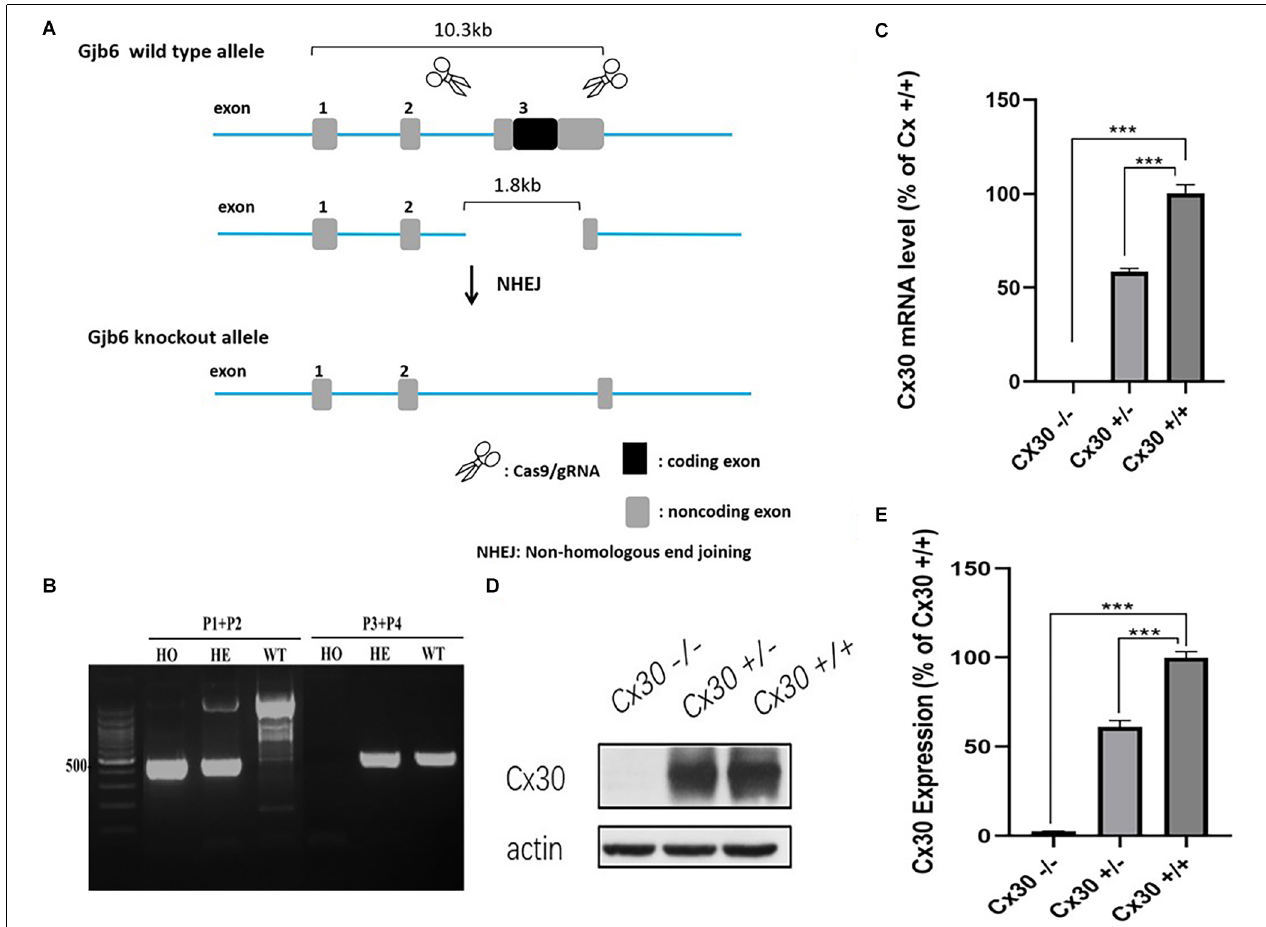
FIGURE 1 | Cx30 -/- mice model. (A) CRISPR/Cas9 technology was used to repair the mutation introduced by non-homologous recombination, resulting in the shift of the protein reading frame of the Gjb6 Exon3 gene. (B) PCR genotyping: Wild type (WT): Gjb6 primer 1 (P1) and P2 PCR to obtain a single 2,369 bp band; Gjb6 P3 and P4 can obtain a 512 bp band; Heterozygous (HE): Gjb6 P1 and P2 PCR to obtain both 527 bp and 2,369 bp bands; Gjb6 P3 and P4 to obtain 512 bp band; Homozygous (HO): Gjb6 P1 and P2 PCR obtained a single 527 bp band; Gjb6 P3 and P4 could not obtain a band. (C–E) Cx30 expression was quantified by qPCR (C) and western blot (D,E) in the whole cochlea. Data presented as Mean ± SEM; three independent experiments; three mice of each genotype per experiment; t -test. *** p < 0.001.